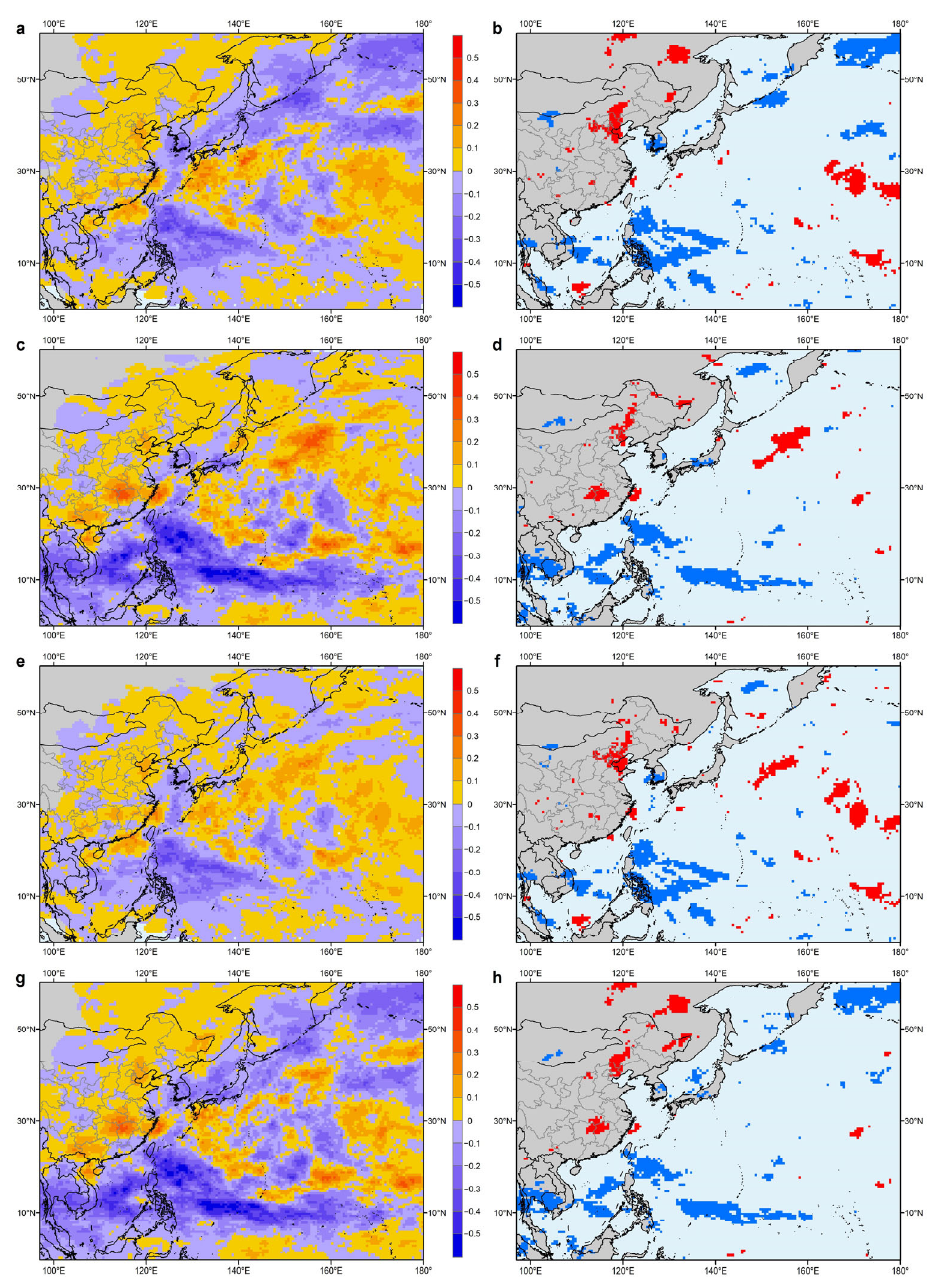
Figure 2. Spatial distribution of tropical cyclone impact frequency change in the Northwest Pacific. ( a , c , e , g ): Spatial distribution of the tropical cyclone impact frequency change over the period 2015–2050 for tropical cyclone hazard scenarios I, II, III, and IV, respectively. ( b , d , f , h ): Regions with significant changes between periods are indicated in red (increased) and blue (decreased) at the 95% confidence level for tropical cyclone hazard scenarios I, II, III, and IV, respectively. Then, we plot the spatial distribution of the change in population in the Northwest Pacific for the period 2015–2050 and the spatial distribution of significant changes ( p ‐ value < 0.05) in Figure 3. It is clear that among the Southeast Asian countries in the Northwest Pacific, with the exception of Cambodia (Myanmar is not in the Northwest Pacific), there has been a significant increase in population. In Northeast Asia, the populations of Japan